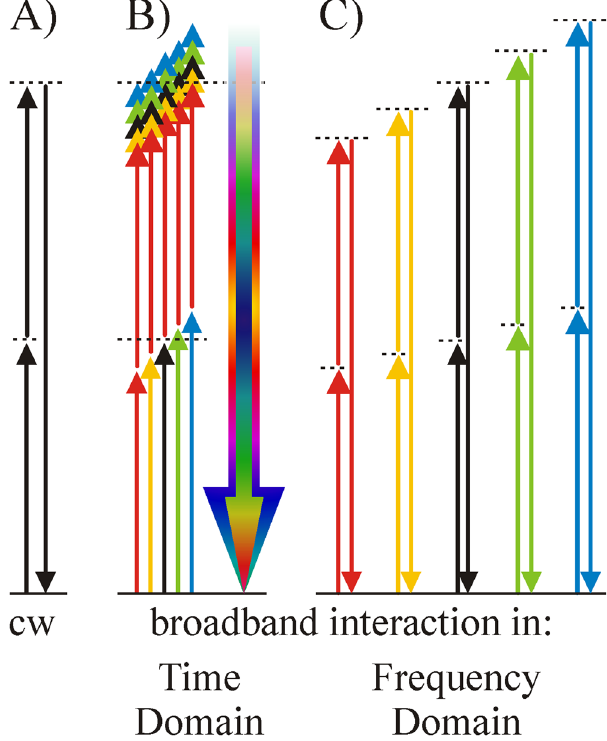
Figure 1. Energy diagrams for different scenarios of nonlinear interaction: ( A ) cw lasers, ( B ) broadband pulses in conventional time domain nonlinear optics (TNO) and ( C ) broadband pulses in frequency domain nonlinear optics (FNO). In TNO ( B ), all frequencies interact simultaneously leading to a mutual convolution of amplitudes and phases. In contrast, FNO ( C ) decouples the frequencies by performing a series of independent “quasi-cw” interactions prior to their recombination back into the time